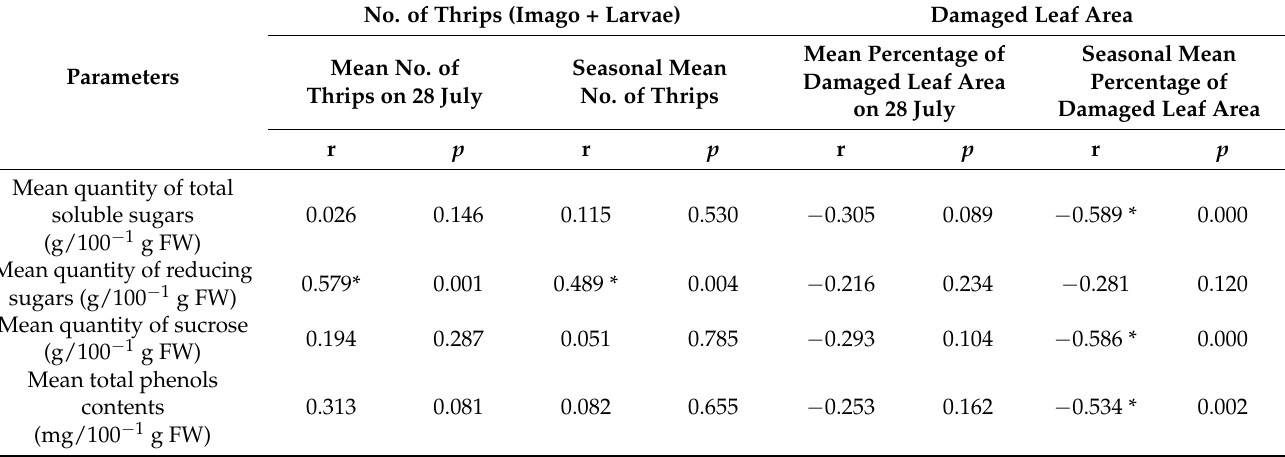
Table 5. Pearson’s correlation between biochemical characteristics of onion leaves and the number of Thrips tabaci and percentage of damaged leaf area of onion leaves in 2015 ( n = 32).